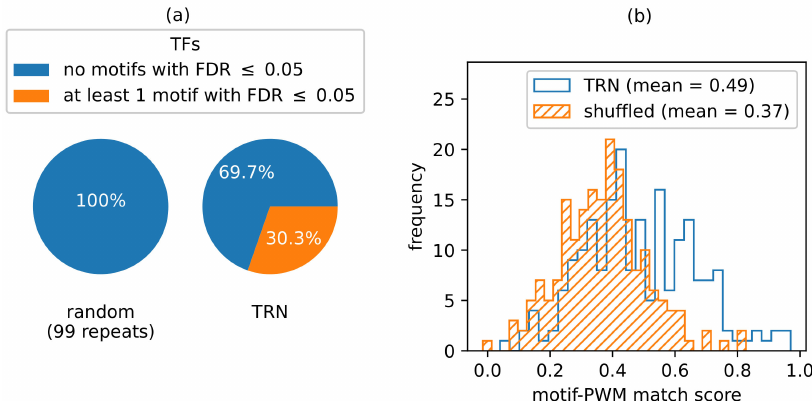
Figure 8. ( a ) Percentage of TFs with at least one significantly enriched motif from the motif enrichment analysis on the original TRN and a randomly shuffled variant. No motifs were enriched with FDR ≤ 0.05 in the randomly shuffled TRN. ( b ) Distribution of match scores with PlantTFDB reference PWMs for the respective transcription factors from all enriched motifs (no FDR cutoff applied) from the original and the randomly shuffled